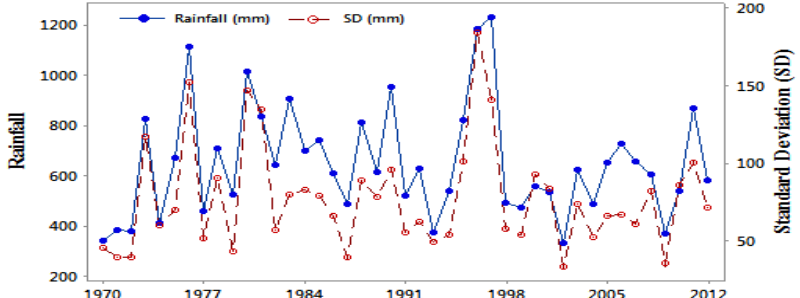
Figure 4. Time series of the standard deviation of the total annual rainfall of Lahore district within 1970–2012.